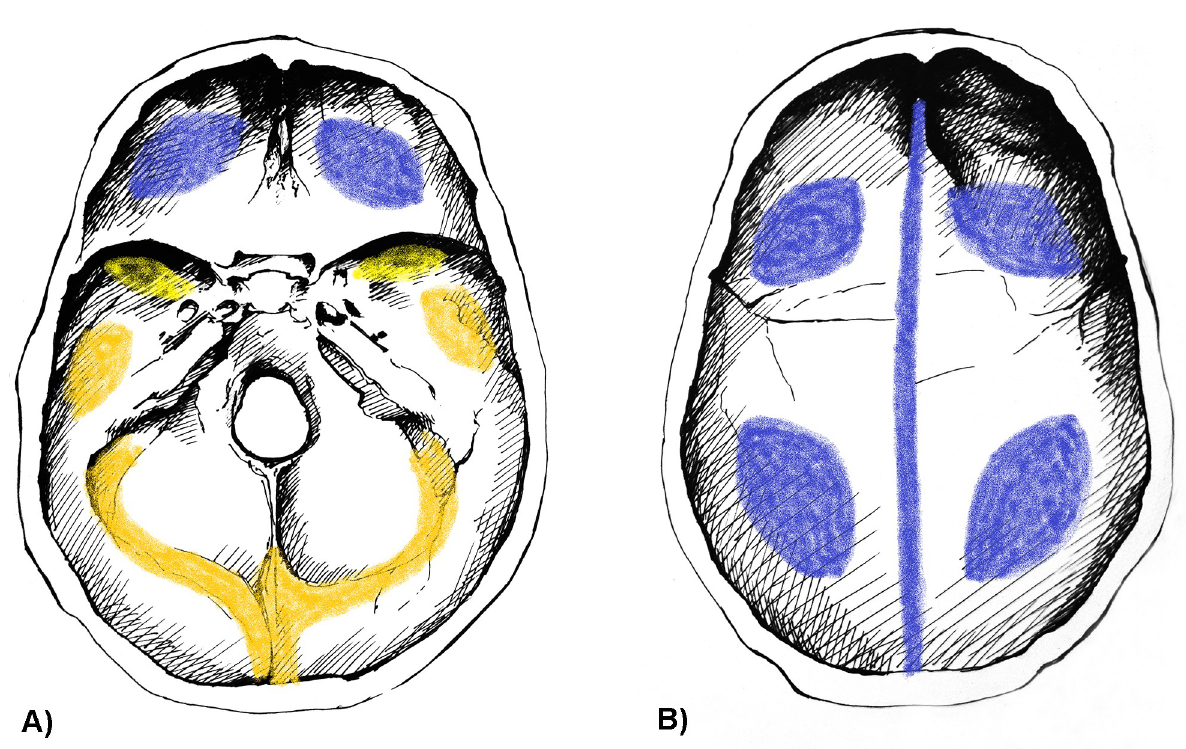
Fig 7. Typical localizations of PAs on the inner surface of the A) skull base and B) skullcap. Blue: most commonly affected areas, orange: commonly affected areas, and yellow: less commonly affected areas (drawings by Luca Kis).